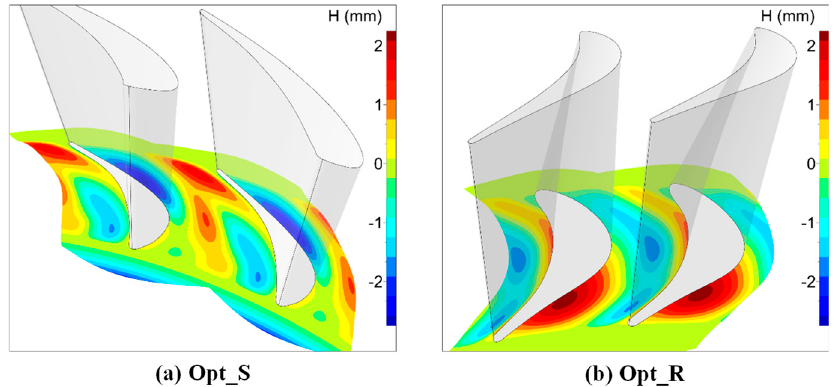
Figure 6. ( a , b ) Endwall height variation in the radial direction of the optimal designs.